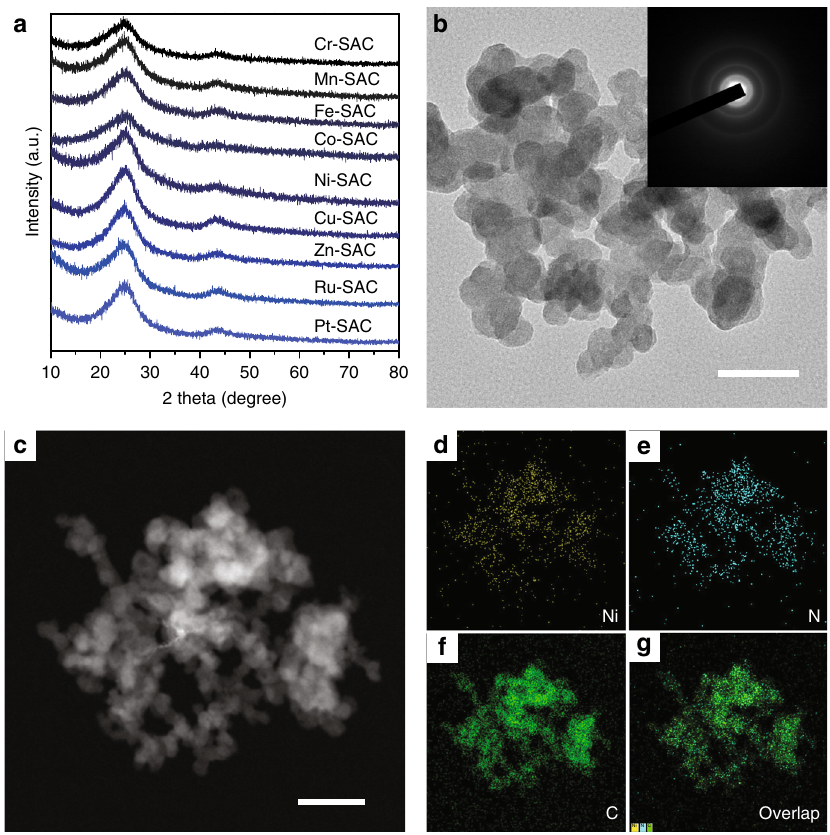
Fig. 2 Characterization of metal single-atom catalysts. a XRD patterns for different metal single-atom catalysts. b TEM image and SAED pattern (inner) for Ni-SAC-2.5, scale bar 100 nm. c STEM image for Ni-SAC-2.5, scale bar 100 nm. d – g EDX maps for Ni-SAC-2.5